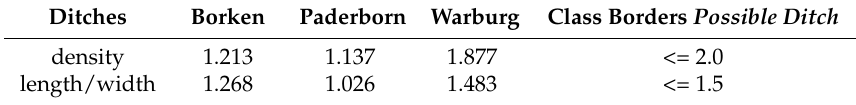
Table 3. Overview of the objects representing the real-life ditches around the mottes and the derived class borders.